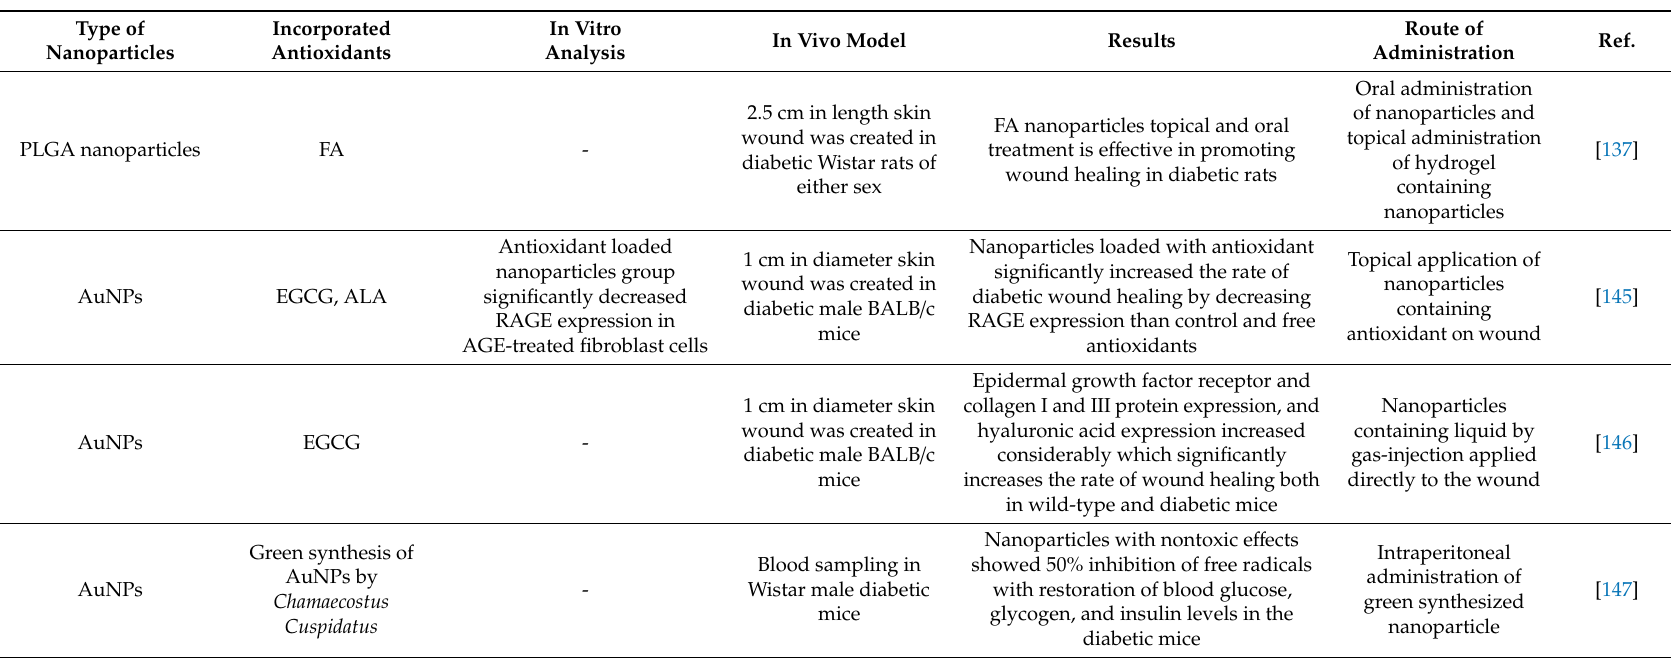
Table 4. Nanoparticles-based therapeutics incorporated with antioxidants for diabetic wound